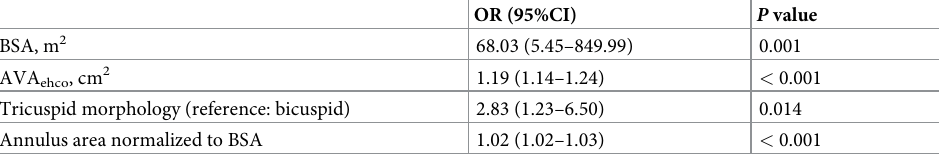
Table 5. Multivariable logistic regression analysis of clinical and CT characteristics to predict the discordance between the aortic valvular areas measured by echocardiography and